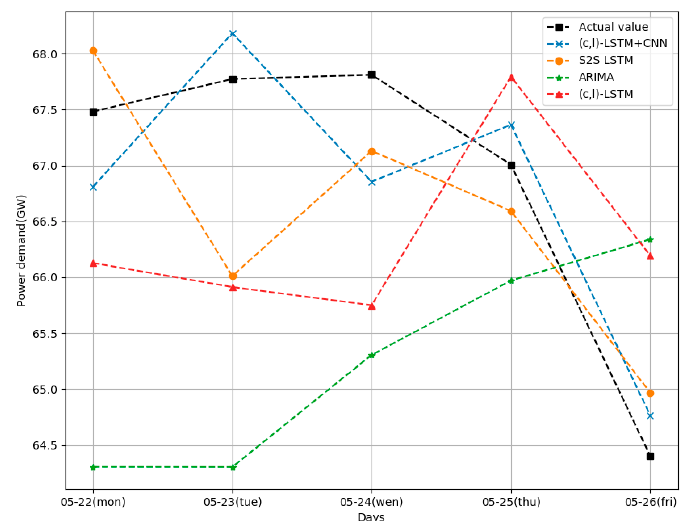
Figure 14. Forecasting performances on d 6 .